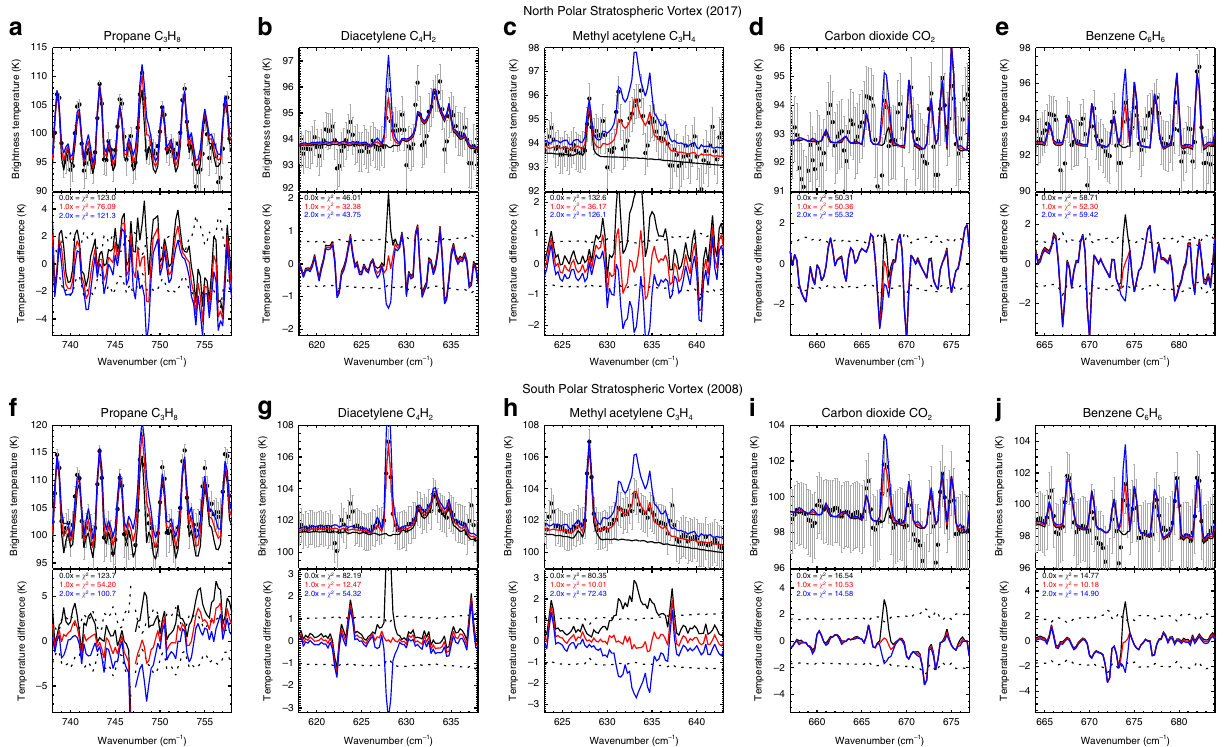
Fig. 7 Detection of minor species within Saturn ’ s northern and southern polar vortices. The NPSV was observed in March 2017 ( a – e ), the SPSV was observed in July 2008 ( f – j ), using the same data as in Fig. 6. Five minor species are shown: propane ( a , f ), diacetylene ( b , g ), methyl acetylene ( c , h ), carbon dioxide ( d , i ), and benzene ( e , j ). Once the best- fi tting atmospheric pro fi les (temperatures and hydrocarbons) had been established, we scaled the abundance of fi ve minor species by 0.0 (black), 1.0 (red) and 2.0 (blue) times to show their detectability in the spectrum. For each panel and gaseous species, we show the brightness temperature spectrum and its uncertainty, as well as the difference spectrum between the data and the model. The goodness-of- fi t is reported for each model, with a Δ χ 2 >1 signifying a 1 σ